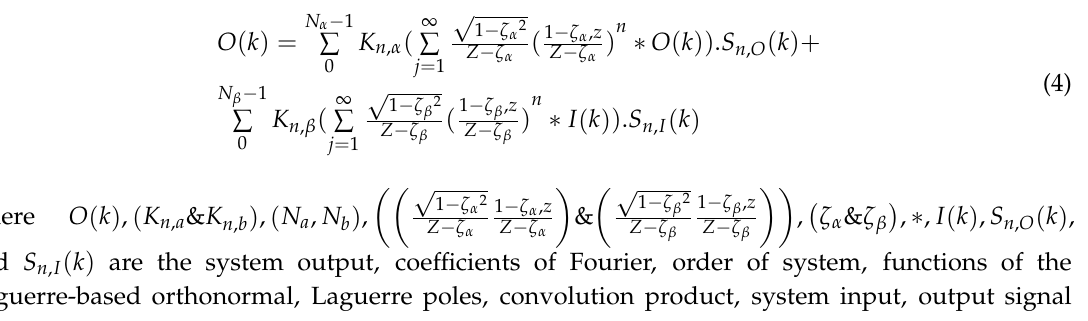
Figure 5. Block diagram of the sliding mode extended-state ARX-Laguerre PI observer for fault diagnosis in an induction motor.